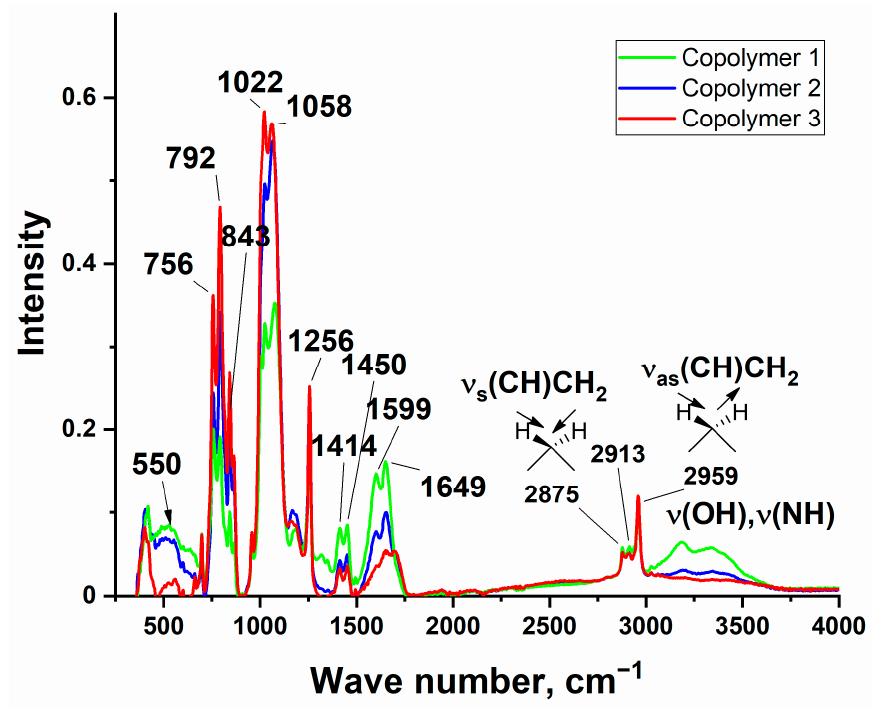
Figure 1. IR spectra of copolymers with 1 wt.% CoAcr 2 PhTpy: copolymer 1—AAm/AAc 84.5/14.5; copolymer 2—AAm/AAc = 49.5/49.5; copolymer 3—AAm/AAc = 14.5/84.5.